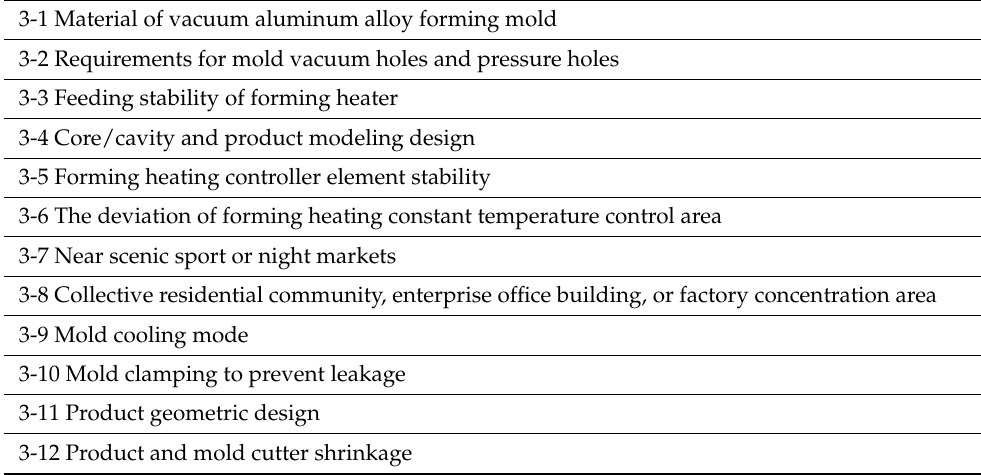
Table 4. Key factors of polypropylene forming and mold manufacturing (12